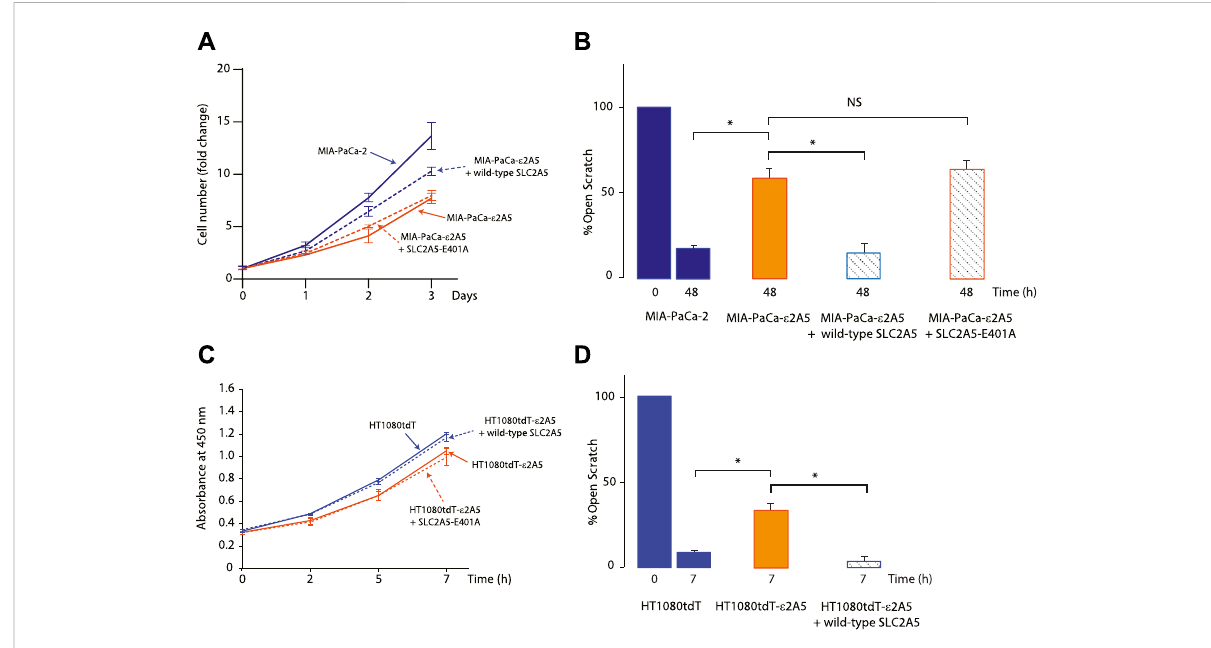
FIGURE 5 Restoration of SLC2A5 function via SLC2A5 transgene expression. Proliferation assay (A) and scratch test assay (B) of MIA-PaCa-2, MIA-PaCa- ε 2A5 (clone F11) and MIA-PaCa- ε 2A5 cells expressing wild-type SLC2A5 or the non-functional SLC2A5-E401A mutant (Nomura et al., 2015) (* p = 0.002; n = 3). In (A) , fold change in cell number is shown at day 0 to day 3. In (B) , the percentage of open scratch is shown at time 0 and 48 h. Proliferation assay (C) and scratch test assay (D) of HT1080tdT, HT1080tdT- ε 2A5 cells transfected with expression vectors encoding wild-type SLC2A5 or the non-functional SLC2A5-E401A mutant (* p = 0.001, n= 3). In (C) , theabsorbance at 490 nm (OD 490 )of theculture medium after MTS assay from time 0 and 7 h in culture is shown. In (D) , the percentage of open scratch is shown at time 0 and 7 h. NS, not signi fi cant. All data in the Figure is representative of more than 3 experiments with 3